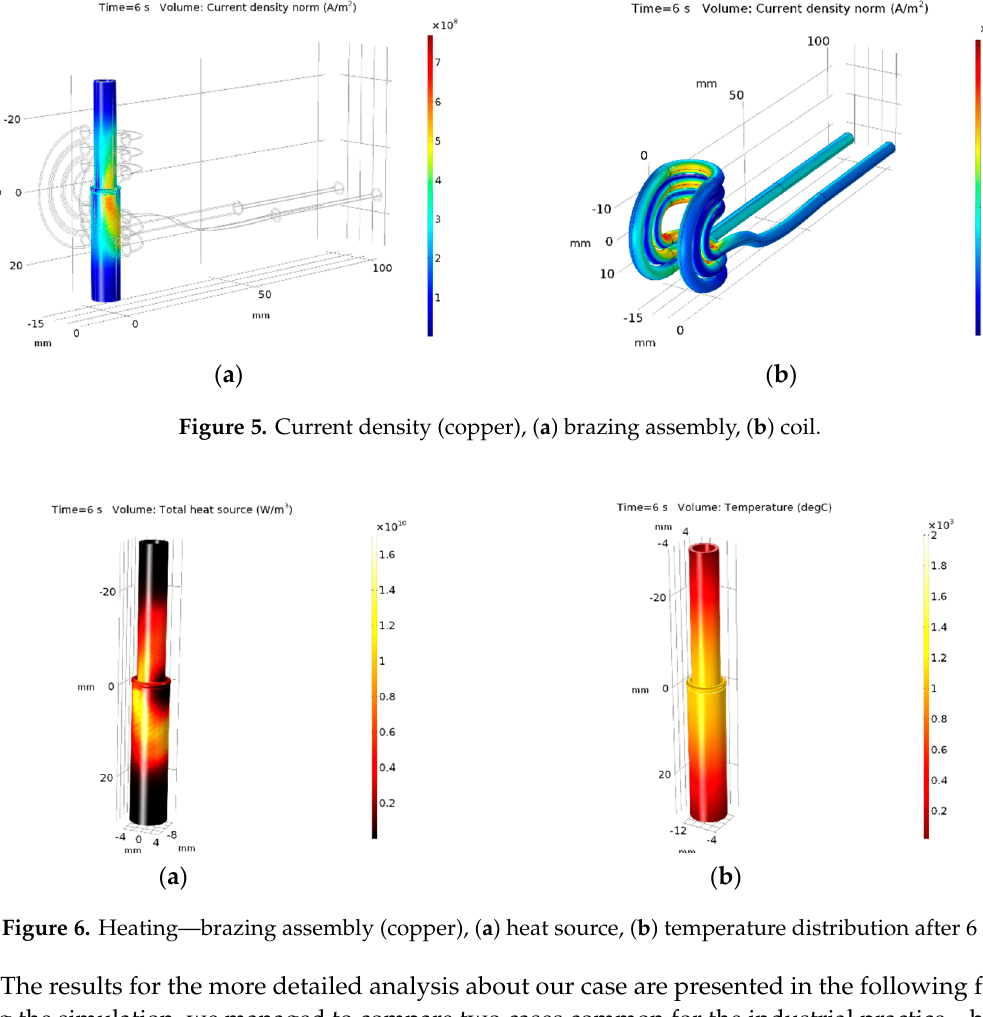
( b ) Figure 3. Magnetic flux density—coil and brazing assembly, Bm, (mT), ( a ) front view, ( b ) side view. ( a ) ( b ) Figure 4. Magnetic flux vector—coil and brazing assembly, ( a ) top view, ( b ) side view. The electric current is one of the key parameters of the whole process. Its surface density